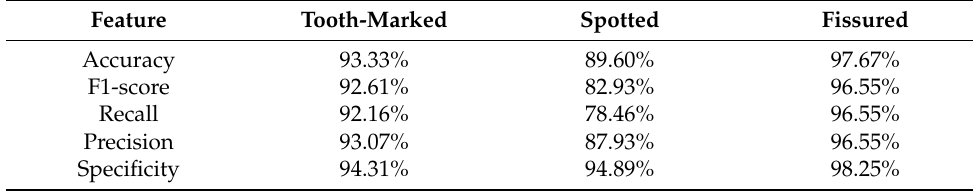
Table 5. The best results of different datasets.